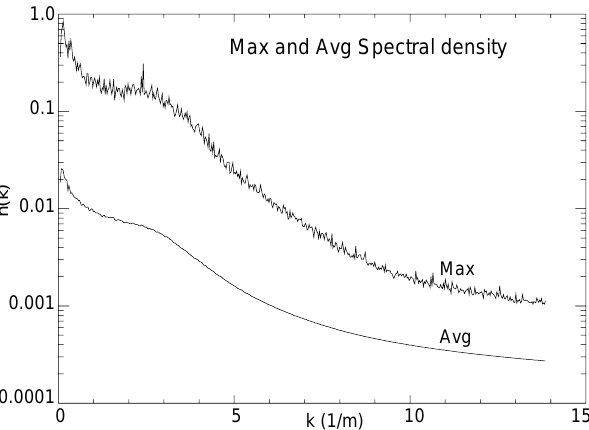
Fig. 9. Power as a function of | k | and ω . This is generated by summing over all the angles from spectra like those seen in Fig. 5. The “max” curve shows the n( | k | ,ω) with the highest ω while the “avg” curve averages n( | k | ,ω) over all ω